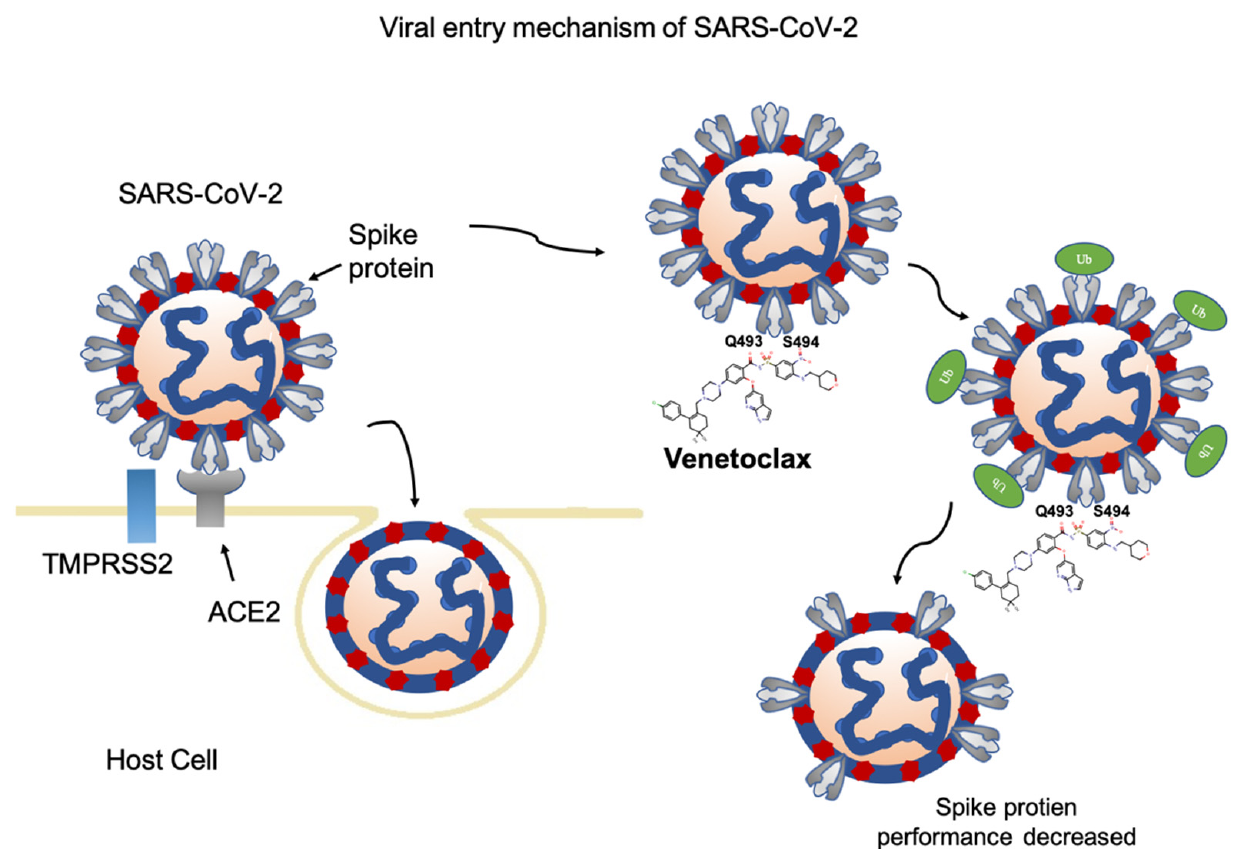
Figure 7. Flowchart showing the methods by which Venetoclax blocks the interaction between SARS-CoV-2 and the ACE2 receptor in the host cell.